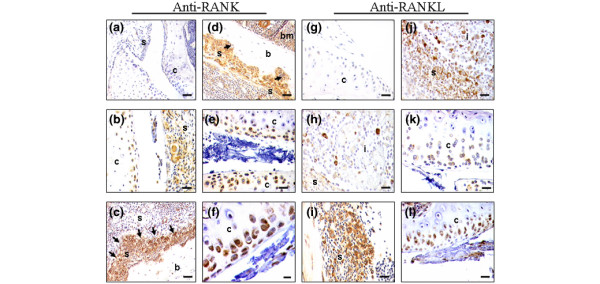
Intra-articular overexpression of oncostatin M (OSM) with either IL-1 or tumour necrosis factor alpha (TNF-α) increases RANK/RANKL expression in murine joints. Mice were injected intra-articularly with adenoviral vectors as described in Fig. 1, and the animals were sacrificed at day 7 following administration. Sections (n = 4 per treatment group) were immunolocalized with antibodies specific for (a)–(f) RANK or (g)–(l) RANKL with haematoxylin counterstaining. No positive staining (brown) was observed in the controls (a and g), while similar patterns of RANK and RANKL staining were observed in the synovium and inflammatory cells in joints treated with a single cytokine (representative data are shown: (b) TNF-α, (h) IL-1). This expression was further enhanced by the combinations of OSM + IL-1 (c, e, i, k) or OSM + TNF-α (d, f, j, l), especially at sites of bone erosion (arrows). A marked increase in RANK and RANKL expression was also seen in the articular chondrocytes for both cytokine combinations (e, f, k, l). b, bone; bm, bone marrow; c, cartilage; i, inflammatory cells; s, synovial cells. Bar = 50 μm.